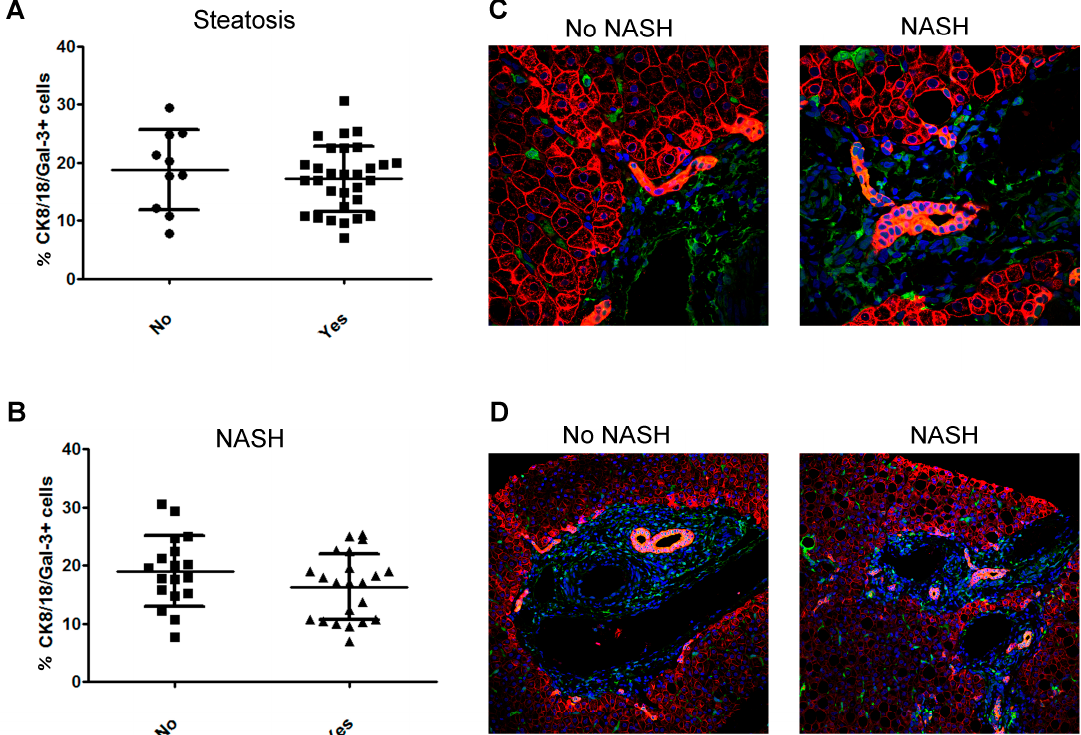
Figure 4. Analysis of the number of hepatic CK8 / 18 / Gal-3 + cells in children with NAFLD associated with severity of disease. ( A , B ) Percentage of CK8 / 18 / Gal-3 + cells in the liver tissue from children with NAFLD correlated with degrees of steatosis ( A ) and the presence of NASH ( B ). ( C , D ) Representative image of immunofluorescence of CK8 / 18 expression (red) and Gal-3 expression (green) in liver tissues from children with NAFLD in the presence (NASH) or not (No NASH) of NASH in the periportal zone ( C ) and bile duct ( D ). Magnification 60 × . Nuclei were counteracted with Hoechst staining (blue).